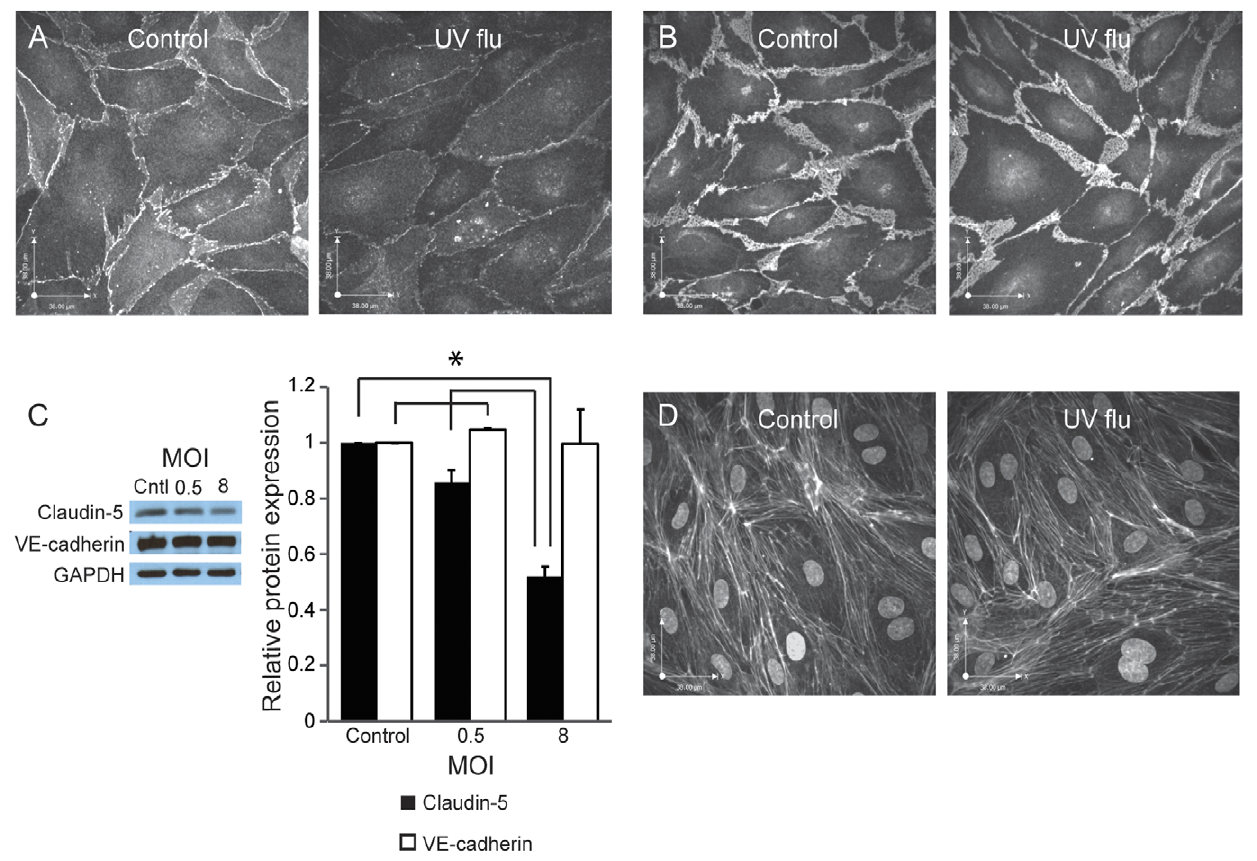
Figure 7. Replication-deficient virus induces loss of claudin-5 while VE-cadherin and F-actin are unaffected. (A,C) Replication-deficient virus induces a loss of claudin-5 as shown by immunofluorescence (A) and western blot (C). In A, cells were infected (MOI 8) for 24 hours. Images are randomly selected and representative of 3 experiments. In C, cells were infected with influenza at the indicated MOI (control =0). Image is representative of 4 experiments; histogram is the quantitation and shows mean and standard deviation and is normalized to control, *p , 0.05. (B) In contrast, replication-deficient virus (MOI 8 in B) does not affect levels or distribution of VE-cadherin as shown by immunofluorescence (B) and western blot (C). Immunofluorescence images are representative of 3 experiments and western blot is from 4 experiments. The histogram is normalized to control. (D) Replication-deficient virus (MOI 8) does not alter the actin cytoskeleton as shown by immunostaining of F-actin with phalloidin. Images are representative of 3